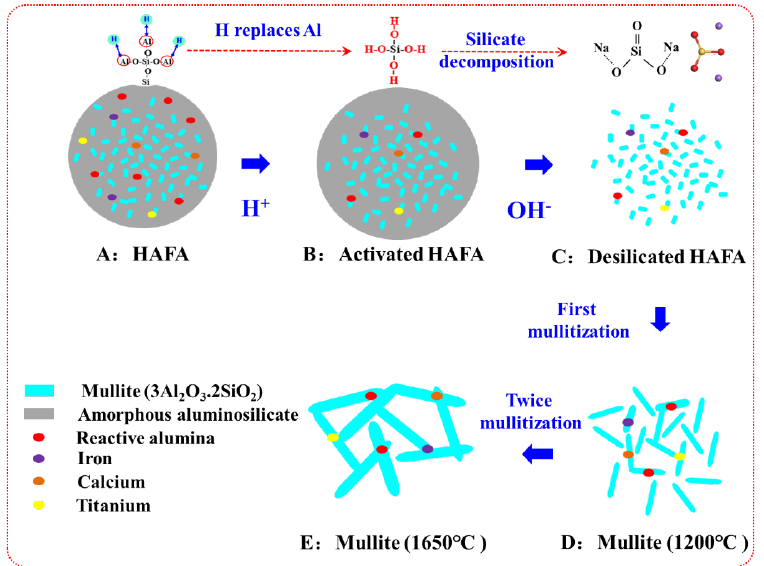
Figure 12. Schematic diagram of mechanism of separation and growth of mullite. ( A - B ): Acid acti- vation; ( B - C ): Deep desilication; ( C - D ): Early mullitization under 1200 °C; ( D - E ): Final mullitization under 1650 °C.